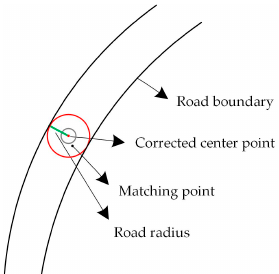
Figure 4. Matching point correction chart.